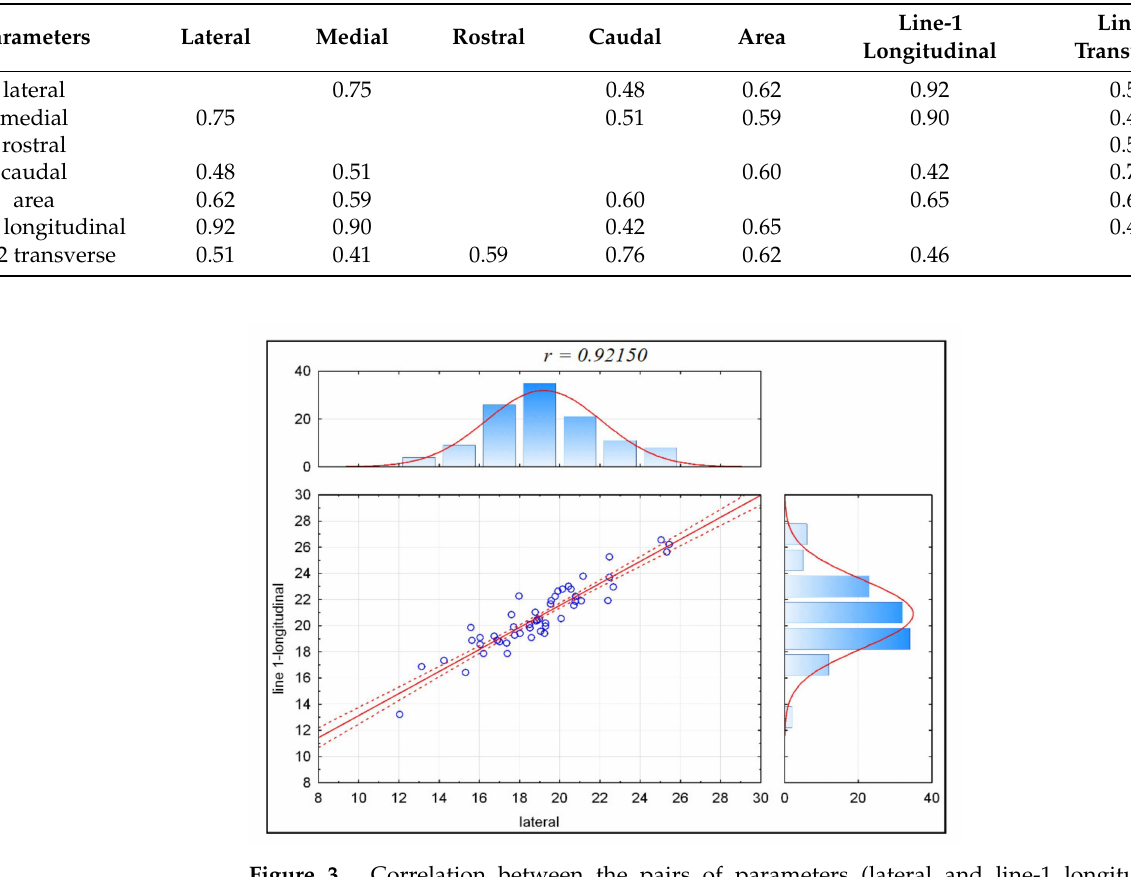
Figure 3. Correlation between the pairs of parameters (lateral and line-1 longitudinal) in whole population.